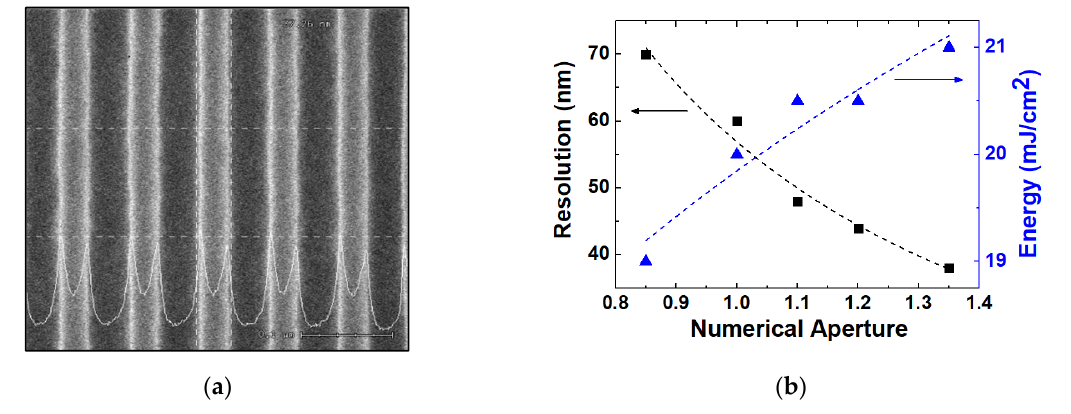
Figure 1. ( a ) Results of CD-SEM of 38 nm line and space pattern after photoresist development (top view) and ( b ) the extracted resolution according to NA where the optimized energy of light source is also illustrated. Energy density to implement the maximum resolution of the NA value. (Here, the 1:1 line and space pattern is used.)